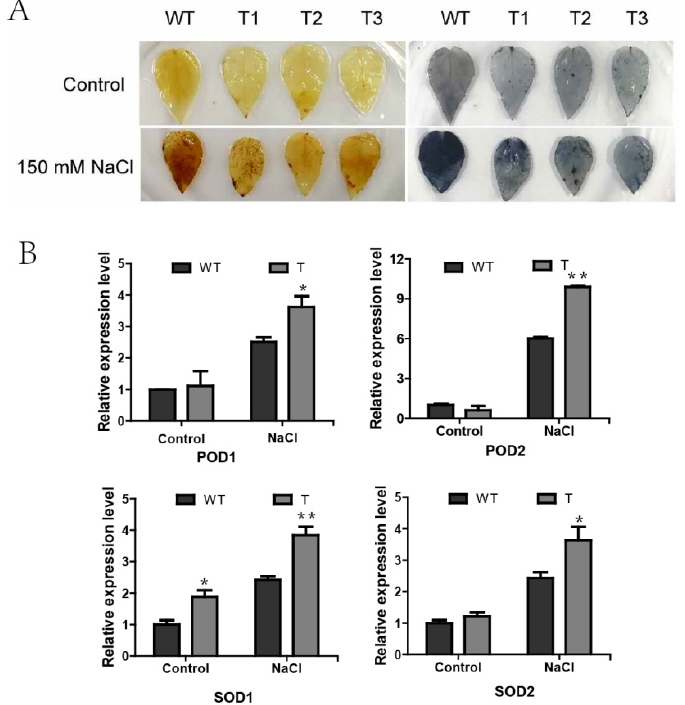
Figure 8. ROS scavenging assay. ( A ) NBT and DAB staining were conducted to detect the content of hydrogen peroxide; WT, wild-type plants; T1–3, transgenic poplar lines overexpressing PagERF072. ( B ) Expression analysis of SODs and PODs. WT, wild-type plants; T, transgenic poplar. Asterisks indicate significant differences between transgenic lines and wild-type lines ( t test, * p < 0.05; ** p < 0.01).